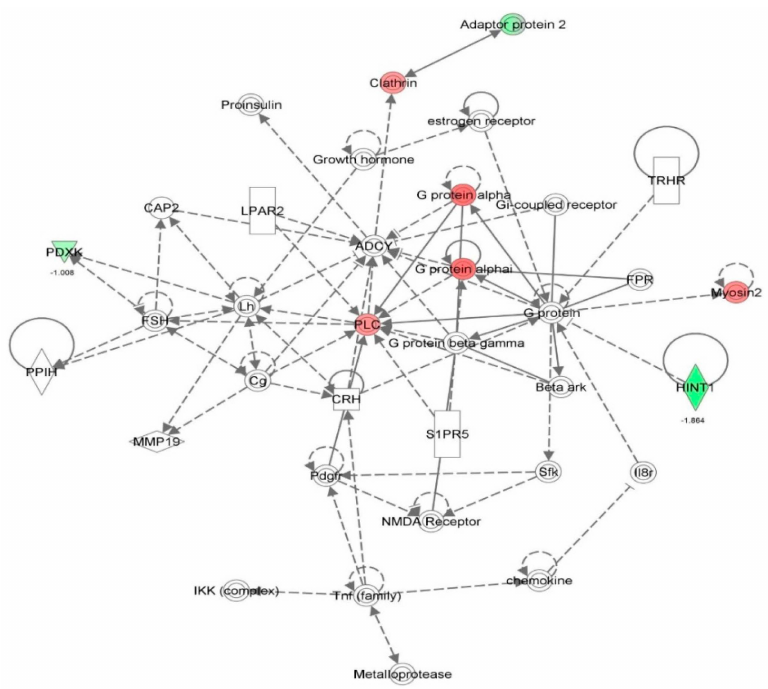
Figure 26. Vancomycin regulated connective tissue development and function, tissue morphology and behavior. Red indicates an up-regulation; green indicates a down-regulation. The intensity of green and red colors indicates the degree of down- or up-regulation. Solid arrow indicates direct interaction and dashed arrow indicates indirect